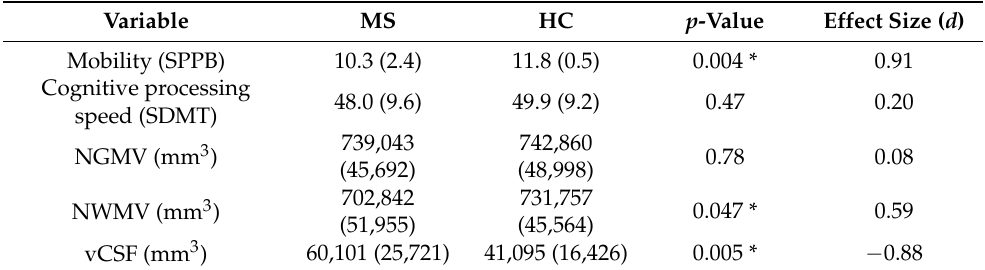
Table 2. Mean values for mobility, cognitive processing speed, and whole-brain MRI metrics.